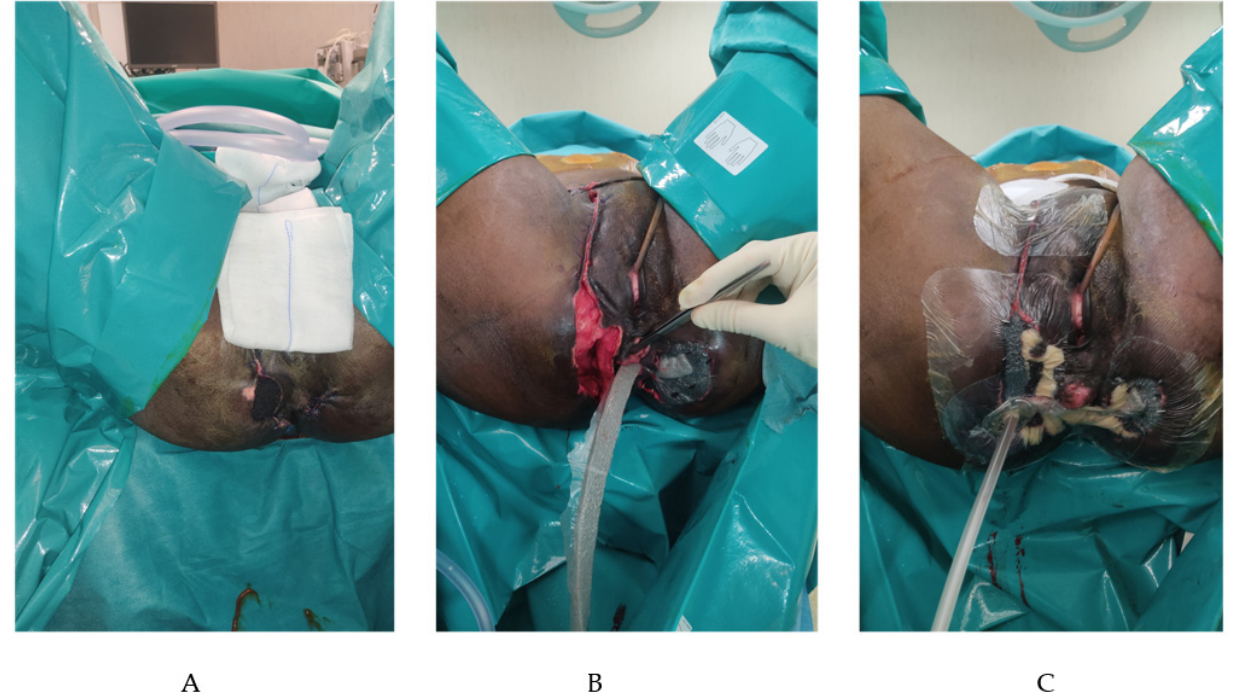
Figure 3. The 3-step eso-endo technique for NPWT positioning in the simultaneous treatment of open perineal wound and rectal fistula. After a complete debridement of necrosis and cleaning of the wound, primary closure of the healthy tissue is performed where feasible. After that, the three-step technique of NPWT placement is achieved. ( A ): A dressing sponge is placed in the cavity in continuity with the rectal fistula (left side) and the other cavity (right side). ( B ): A Steri-Drape fully covered tubular sponge is placed towards the rectal fistula bridging the two previously positioned sponges. So, the suction direction is from the cavity to the rectum, avoiding the solution’ enlargement and promoting the combined healing of both cavity and fistula. ( C ): Steri-drapes are placed, and negative pressure therapy is started. The pressure was stated at − 125 mm/hg in a continuous mode and renewed every 48–72 h.